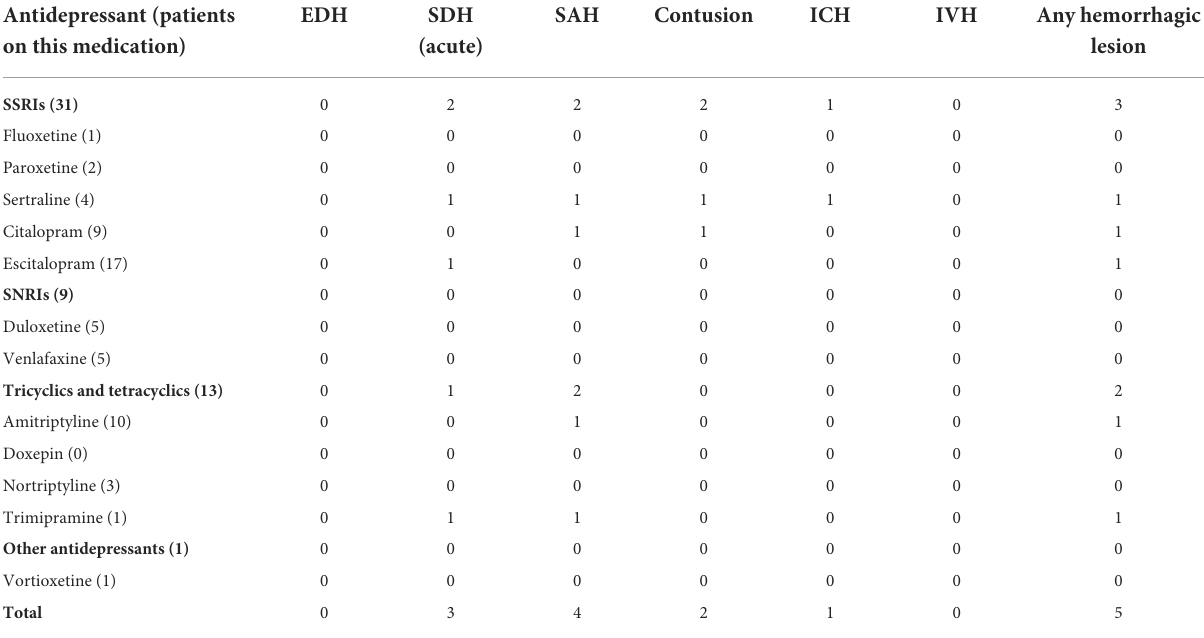
TABLE 5 Cross-tabulation of individual serotonergic antidepressants and hemorrhagic CT lesions. Antidepressant